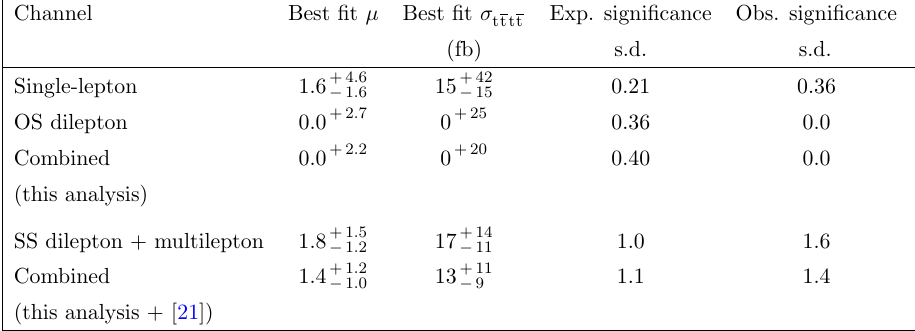
Table 2 . Maximum-likelihood signal strength, (cid:22) , and cross section estimates, as well as the ex- pected and observed signi(cid:12)cance of SM tttt production. Both (cid:22) and (cid:27) are constrained to be tttt positive. The results for the two analyses from this paper are shown separately and combined. The results from a previous CMS multilepton measurement are also given [21]. The values quoted for the uncertainties on the signal strengths and cross sections are the one standard deviation (s.d.) values and include all statistical and systematic uncertainties. The expected signi(cid:12)cance is calculated assuming that the data are distributed according to the prediction of the SM with nominal tttt production cross section value (cid:27) SM , which corresponds to the assumed signal strength modi(cid:12)er tttt value (cid:22) = 1.